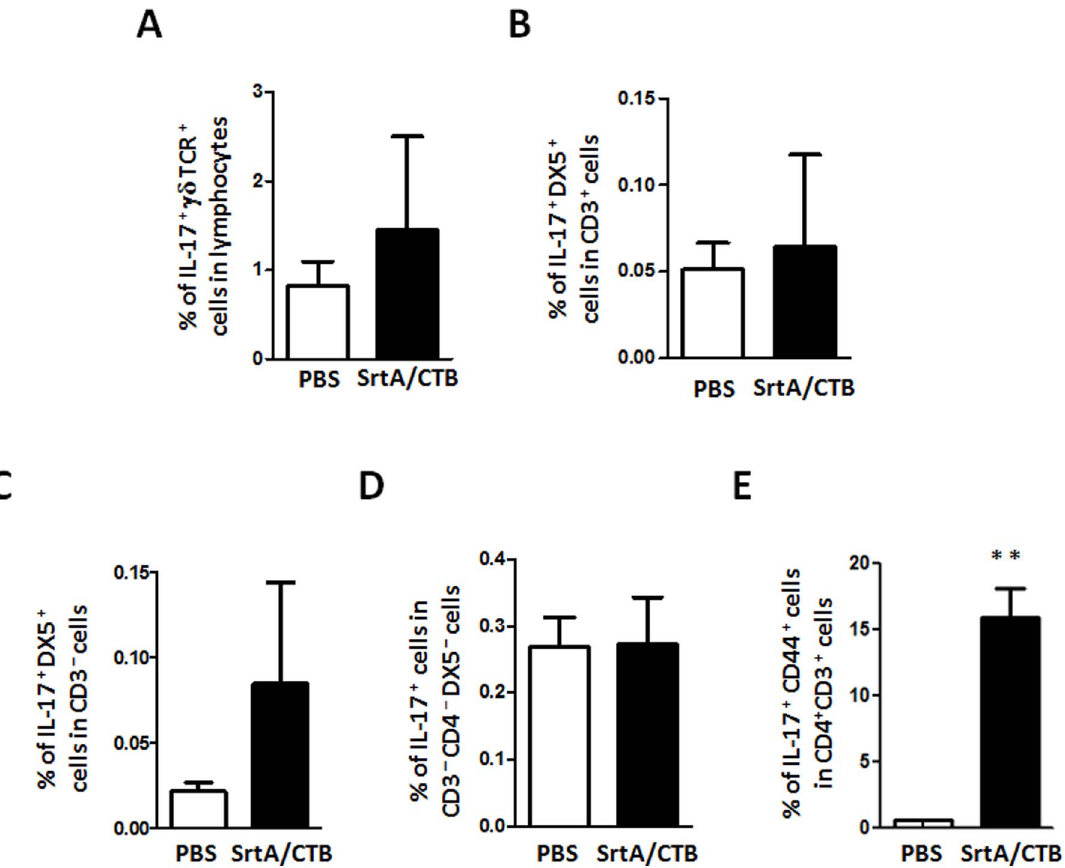
Figure 4. IL-17-producing CD4 + cells were the predominant responsive cell population in SrtA/CTB-immunized mice after GAS challenge. Mice were immunized and challenged as in Fig. 3. Five days after challenge, immunized (SrtA/CTB) and PBS control mice were euthanized and NALT cell suspensions were stained with antibodies for surface markers (CD4, CD3, DX5, and cd TCR) as needed followed by intracellular staining with PE-IL-17 and analyzed by FACS. ( A ) IL-17 + cd TCR + ( cd T) cells. ( B ) IL-17 + DX5 + CD3 + (NKT) cells. ( C ) IL-17 + DX5 + CD3 – (NK) cells. ( D ) IL-17 + CD3 – CD4 – DX5 – (ILC3) cells. ( E ) IL-17 + CD3 + CD4 + CD44 + (memory Th17) cells. Data are means 6 SEM of three mice per group. ** P # 0.01.